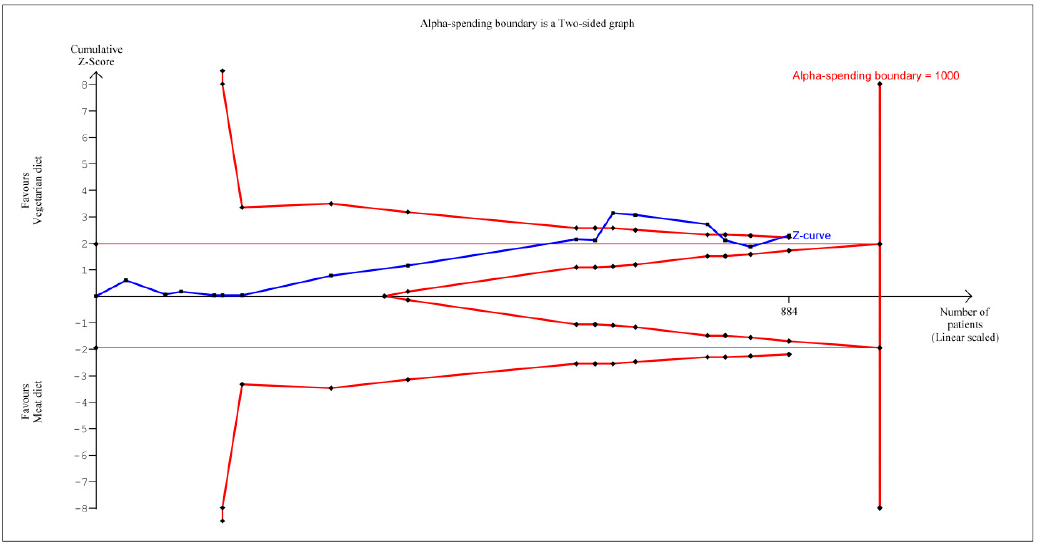
Figure 3. Trial sequential analysis on the effect of vegetarian diets vs. omnivorous diet on diastolic blood pressure reduction.